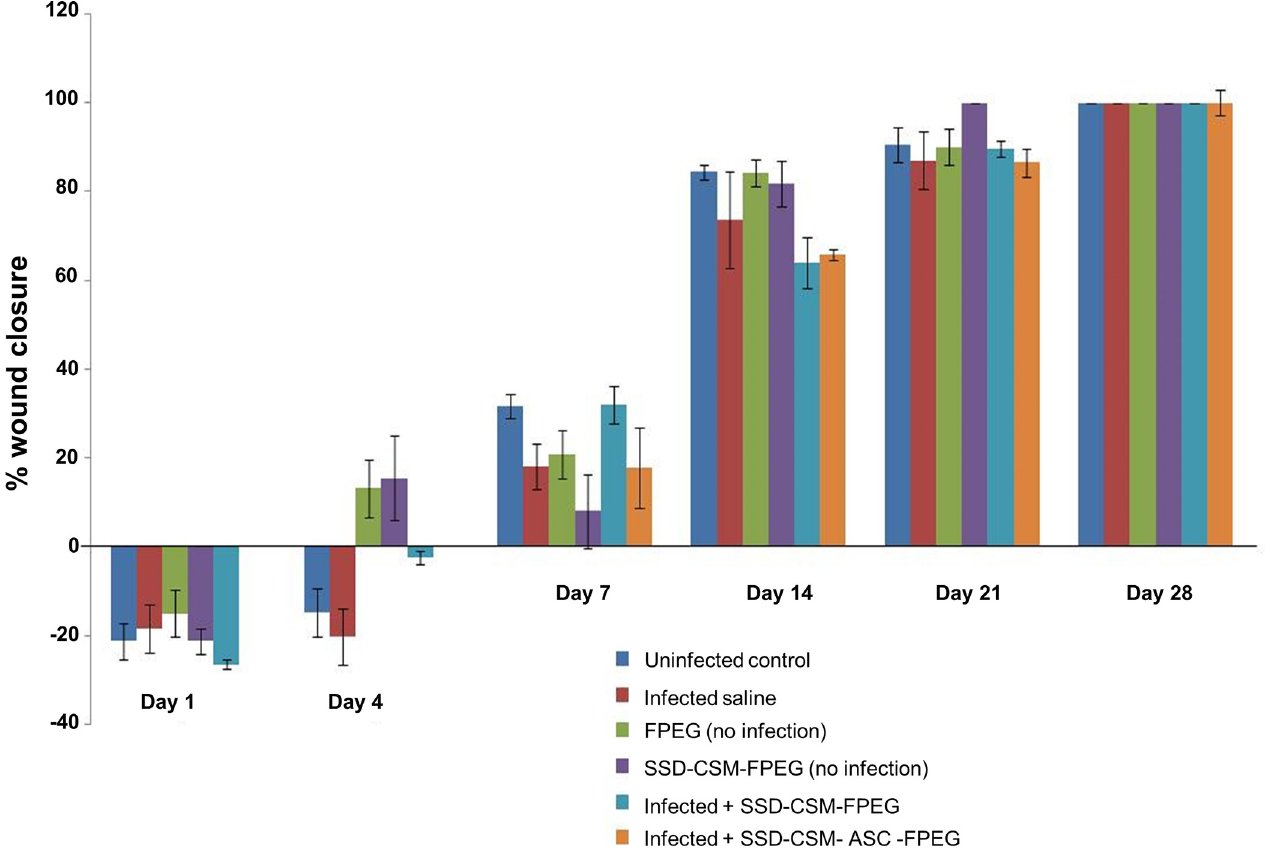
Fig 5. Percentage wound closure observed over 28 days in infected/ non-infected groups treated with SSDM-CSM-FPEG with or without ASCs. ( n = 4).